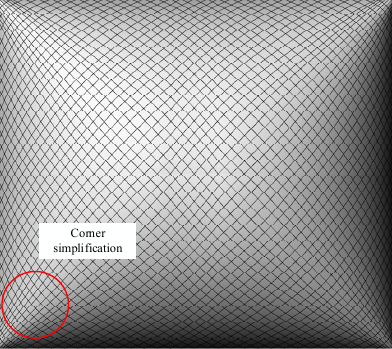
Figure 6. Original model.